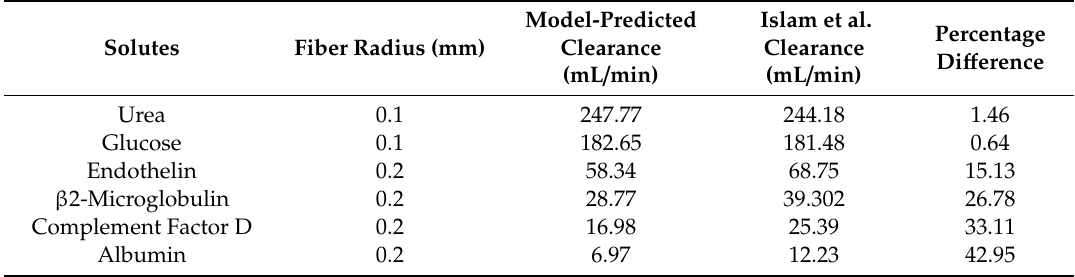
Table 7. Maximum percentage difference of this model with literature data at a varying radius of dialyzer fiber [22].